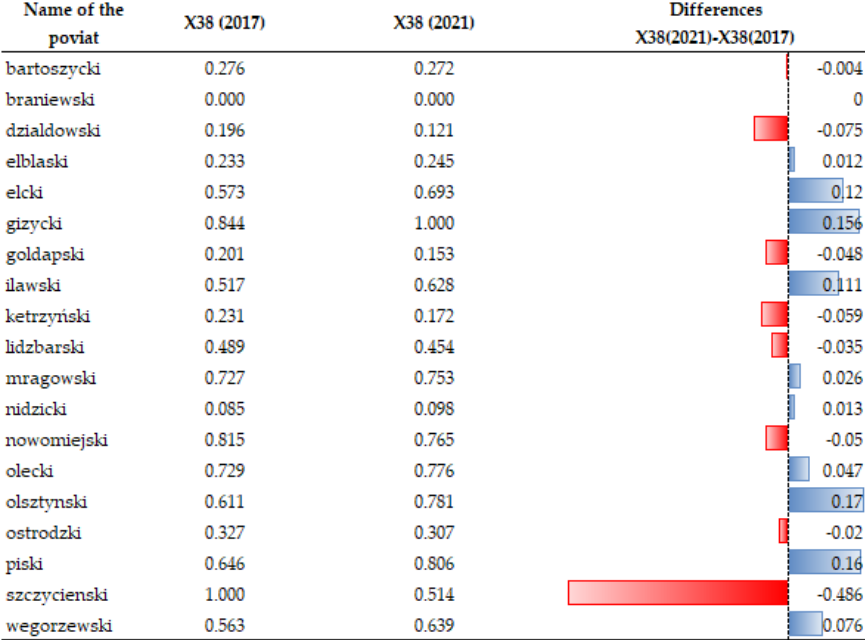
Figure 9. Temporal dynamics of the electricity consumption/ per person (X38). Source: own study.